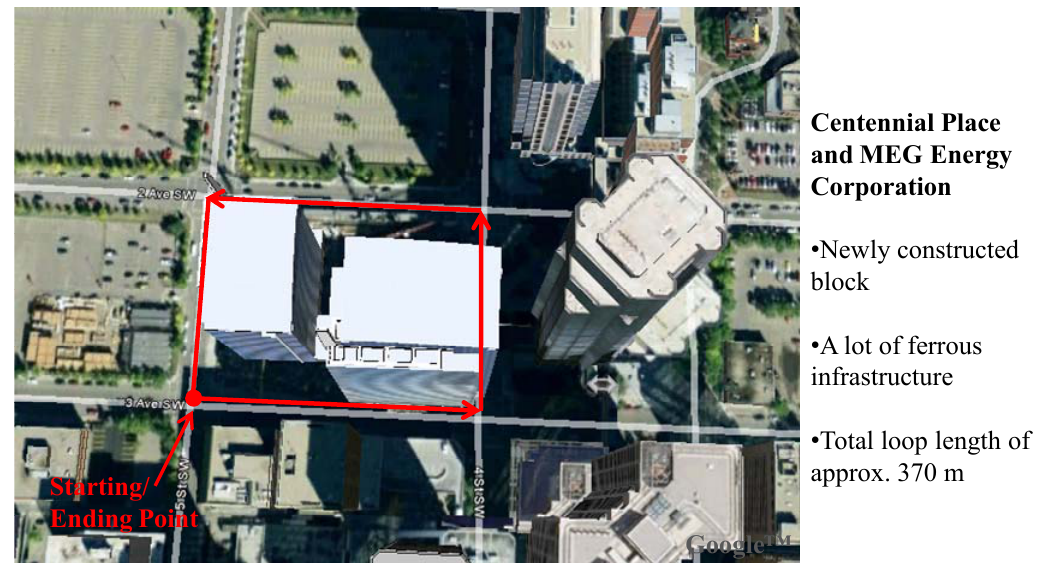
Figure 9. Downtown Calgary data collection